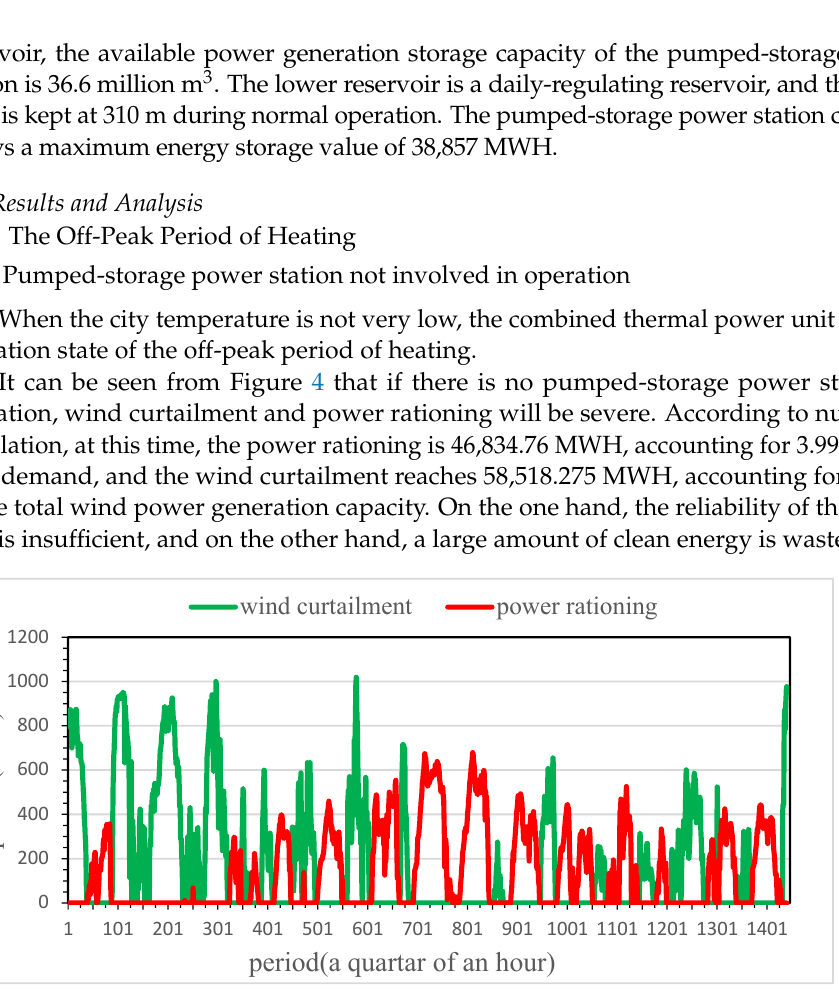
Figure 4. The situation of wind curtailment and power rationing without the pumped-storage power station during an off-peak period of heating.